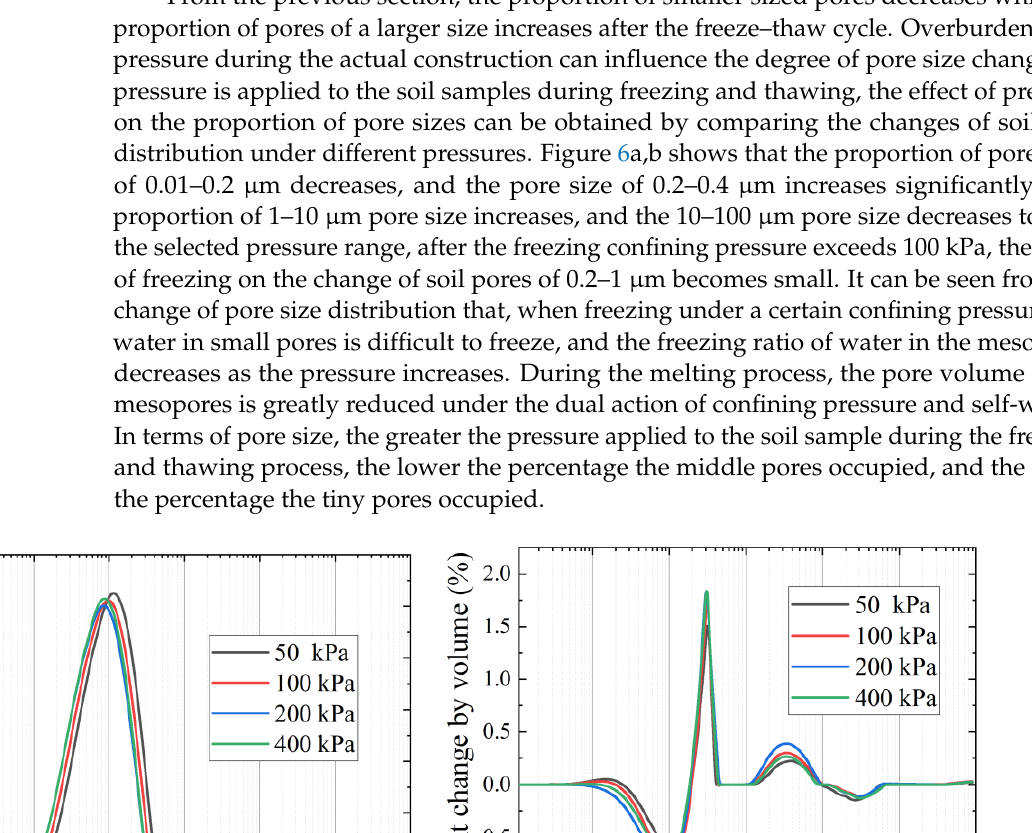
7 of 16 Figure 5. Effect of freezing duration: ( a ) pore size distribution; ( b ) differences in the pore size distri- bution. It is known that unfrozen water is a key part in determining the physical properties of frozen soils [41]; however, for frozen – thawed soil, the water in the frozen part is the key cause of soil microstructure damage. In order to better explain the principle of freez- ing failure, Figure 5b plots the change in porosity proportion under different freezing du-